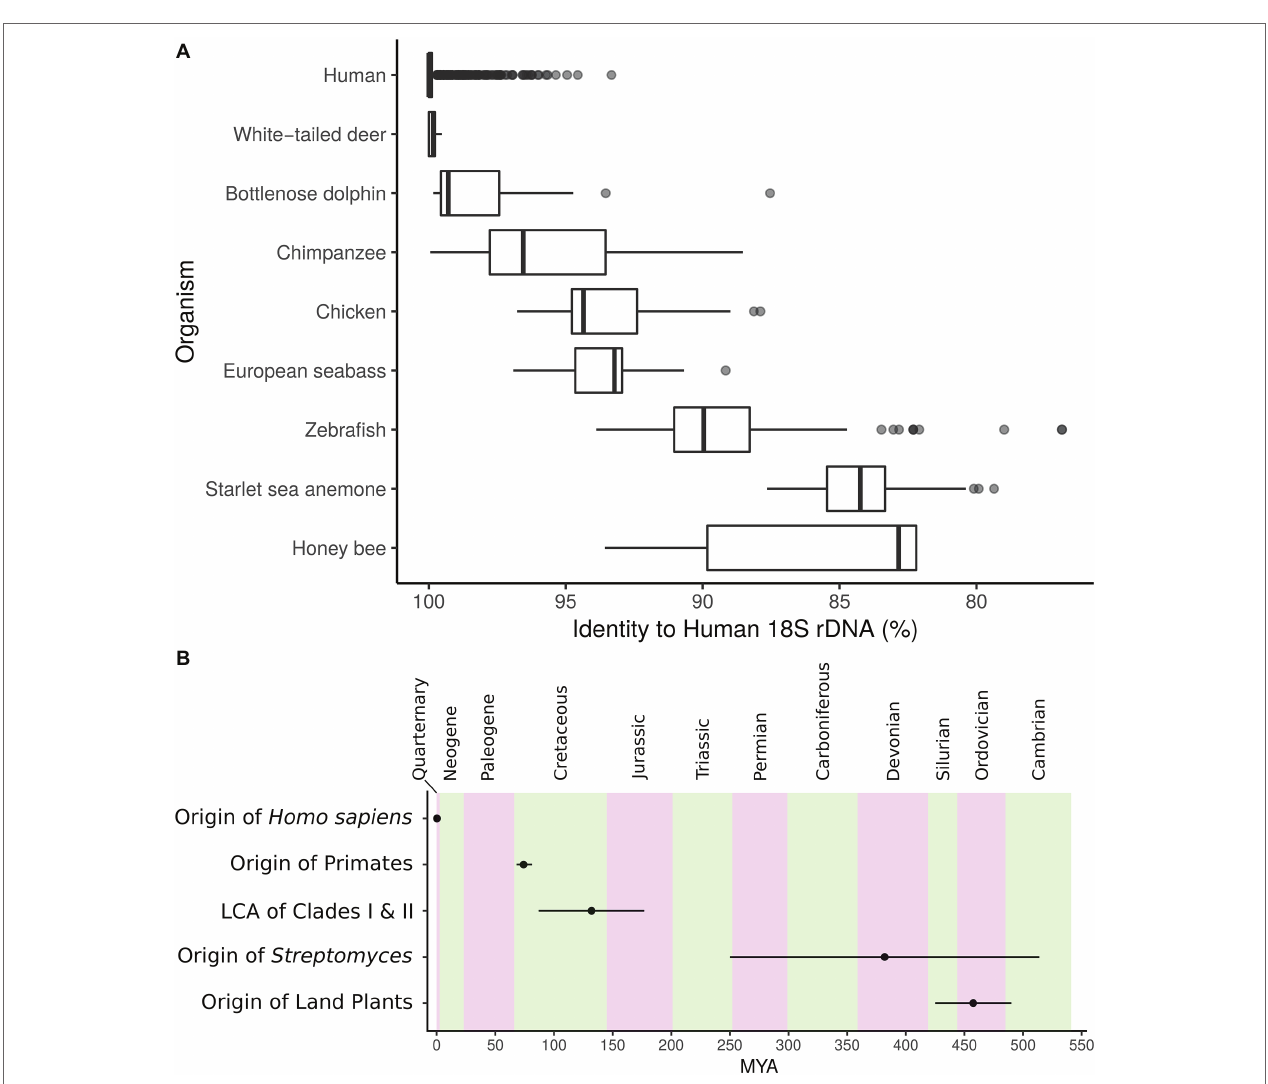
FIGURE 1 | (A) Identity to closest human 18S rRNA gene match for several metazoans. Center, median; box, upper and lower quantiles; whiskers, 1.5× interquartile range; points, outliers. (B) Timeline depicting the origin of Streptomyces and the major split between Streptomyces Clades I and II in relation to other events of interest. MYA, million years ago; error bars, lower and upper confidence estimates. Geologic periods are in alternating